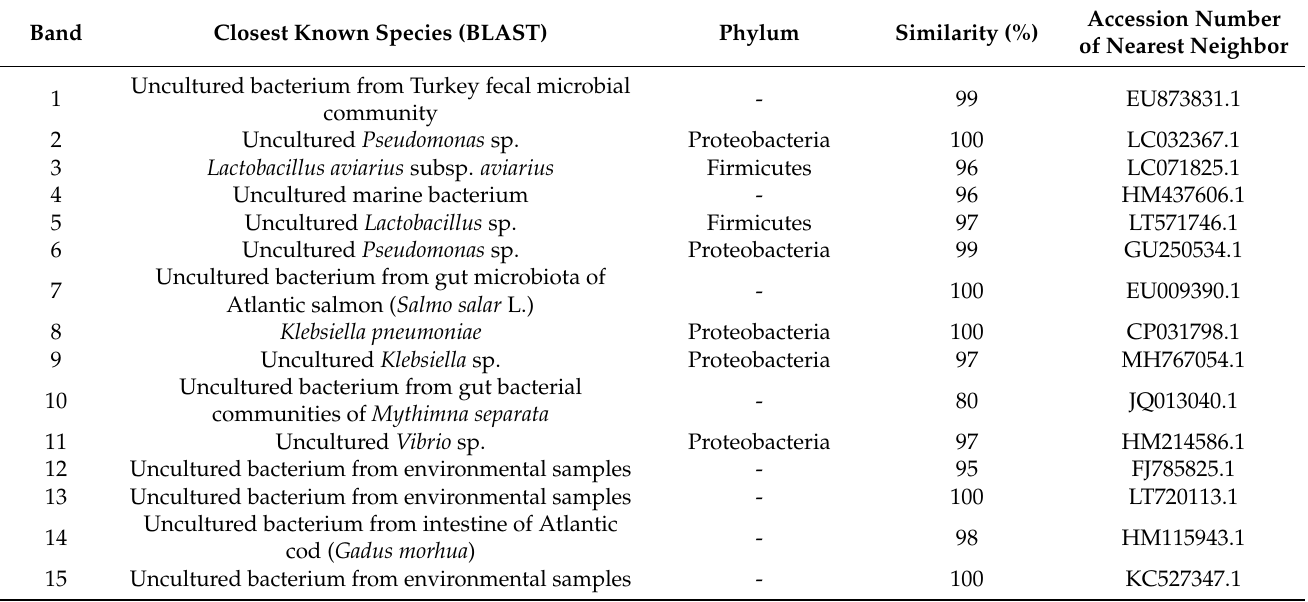
Table 5. Identified bacterial species from the DNA sequencing of the allochthonous and au- tochthonous gut bacteria communities of gilthead seabream fed the experimental diets.